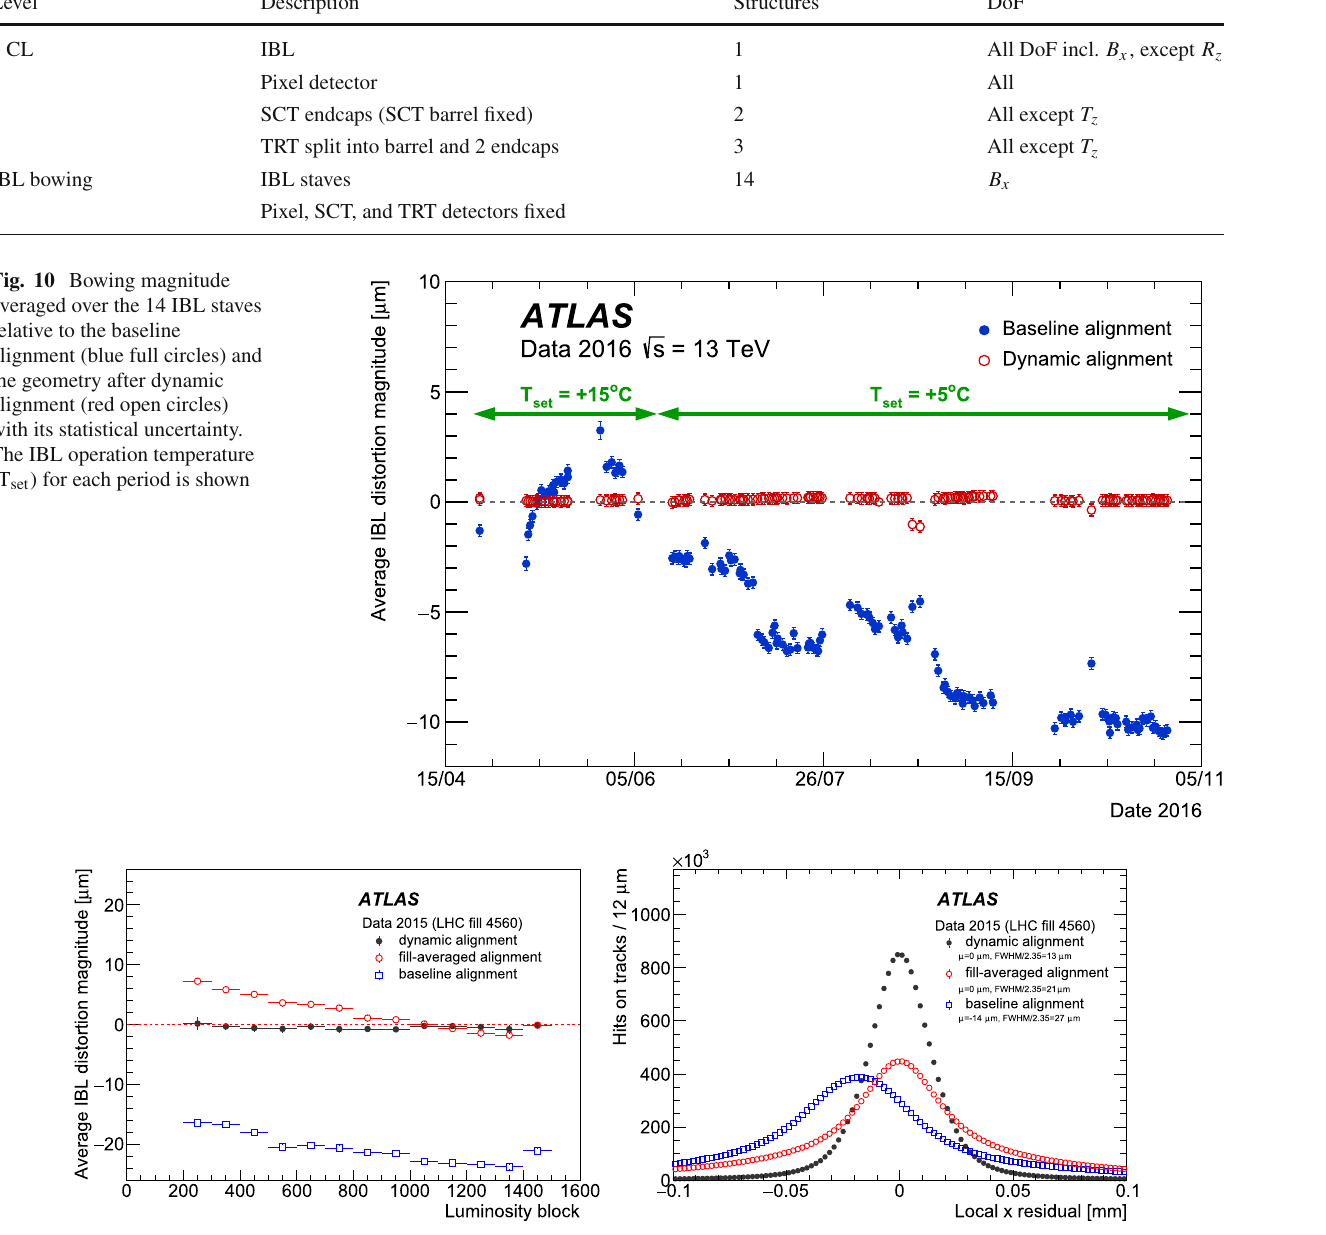
tortion in the transverse plane after the baseline ID alignment. The open red circles show the fill-averaged correction and the solid black circles show the full dynamic alignment